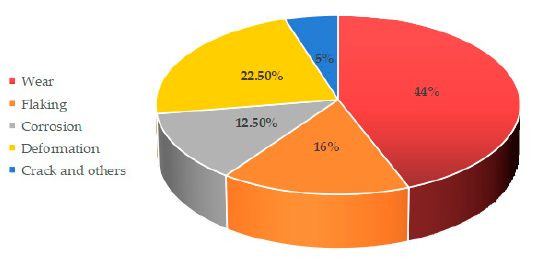
Figure 7. Percentage of frictional failure forms in wind power bearings (Adapted from [63]).